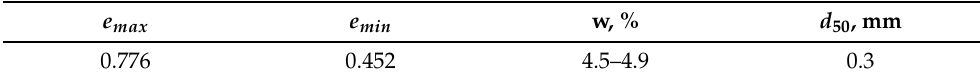
Table 1. Parameters of medium sand.